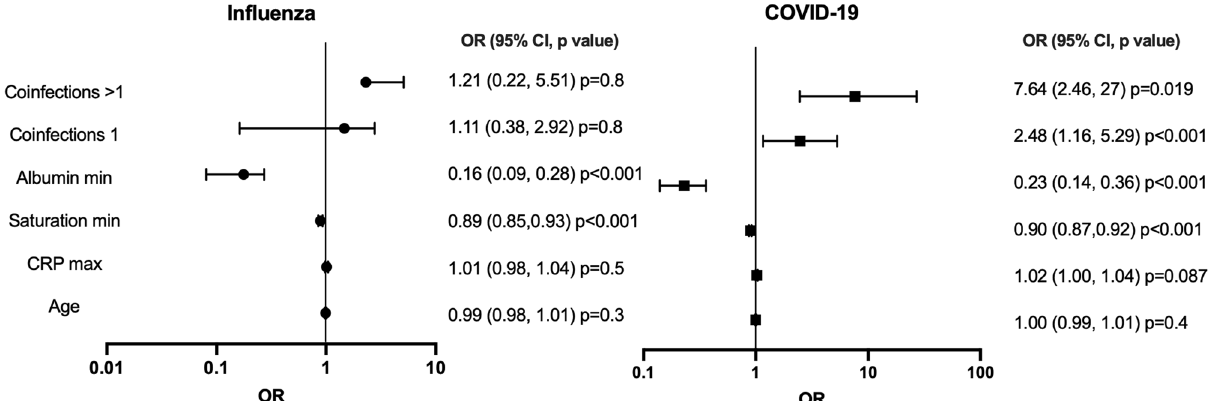
Figure 1. Multivariate analysis of various parameters related to disease severity and their association with death. For each viral infection, the odds ratios (OR) for each parameter and 95% confidence intervals (CI) are plotted.